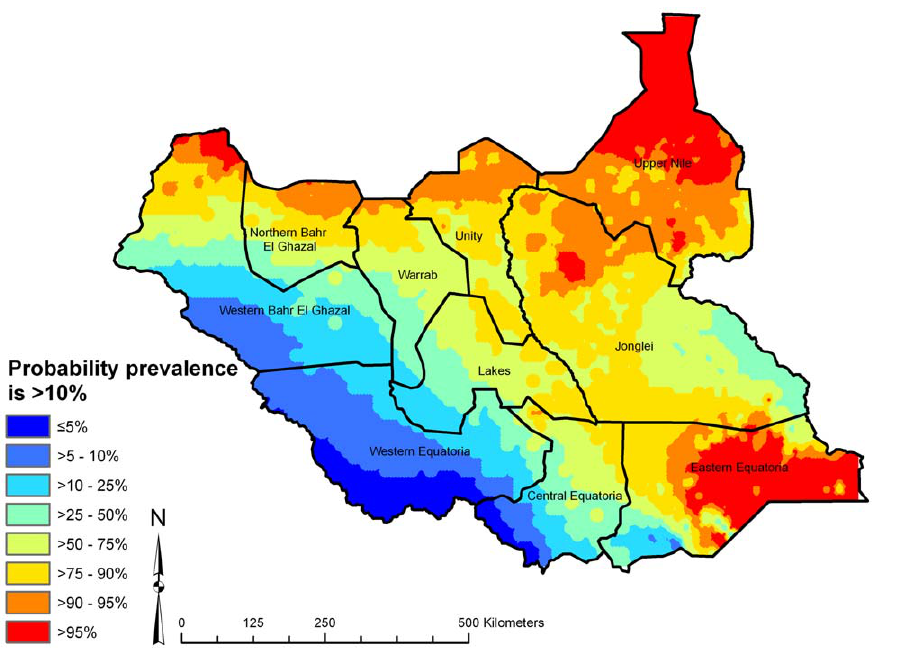
Figure 7. Predicted probability that prevalence of active trachoma is . 10% in children aged 1–9 years, Southern Sudan, 2001– 2009. Estimates were obtained from posterior predictive distributions derived using model-based geostatistics.